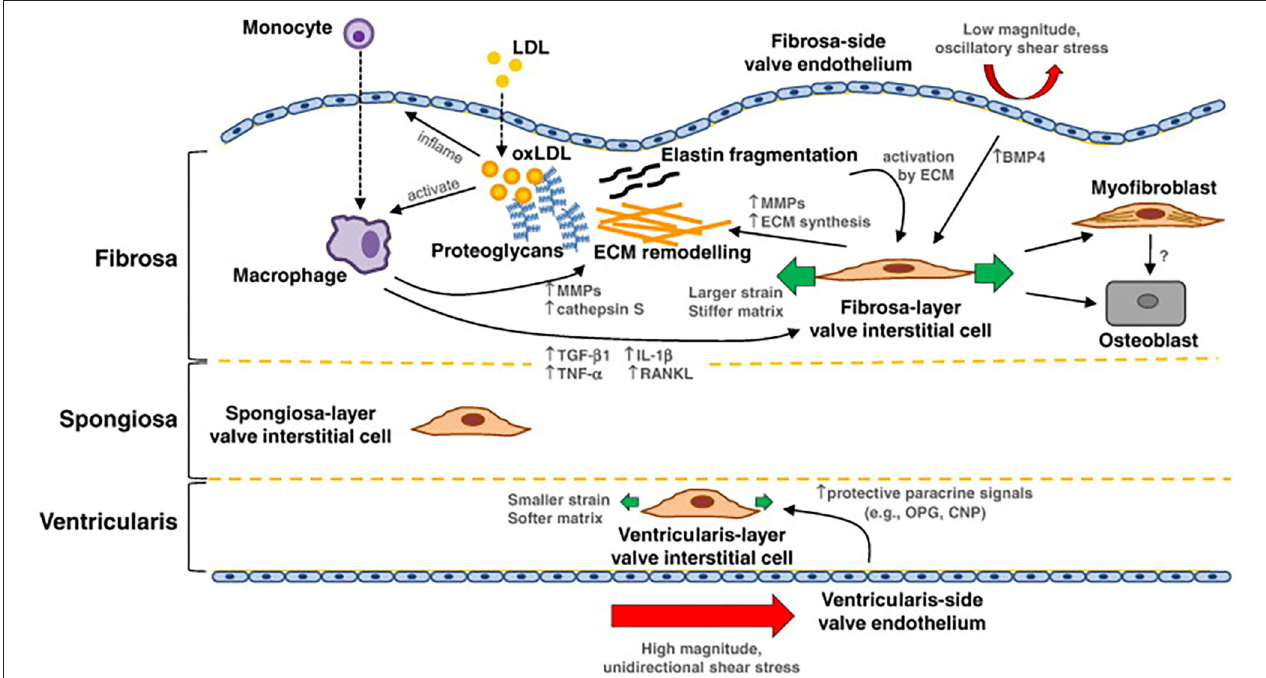
FIGURE 2 | Summary of mechanotransduction and pathway of valvular calcification: in the fibrosa layer, the oxidated LDL (oxLDL) can inflame the endothelial cells, bind to monocytes, and activate macrophages. Activated macrophages mediate extracellular matrix (ECM) remodeling and molecular signaling that can potentiate valvular interstitial cell (VIC) pathological differentiation to myofibroblast and osteoblast cells. The ECM further affects VIC activation and differentiation; activated VICs synthesize and remodel the ECM, and produce cytokines, like TGF- β 1. Interstitial and endothelial cells on each layer of the tissue exhibit a different phenotype. On the ventricular side, endothelial cells experience high magnitude and unidirectional shear stress, which may inhibit pathological differentiation of the local VICs. Image is from Yip et al. with